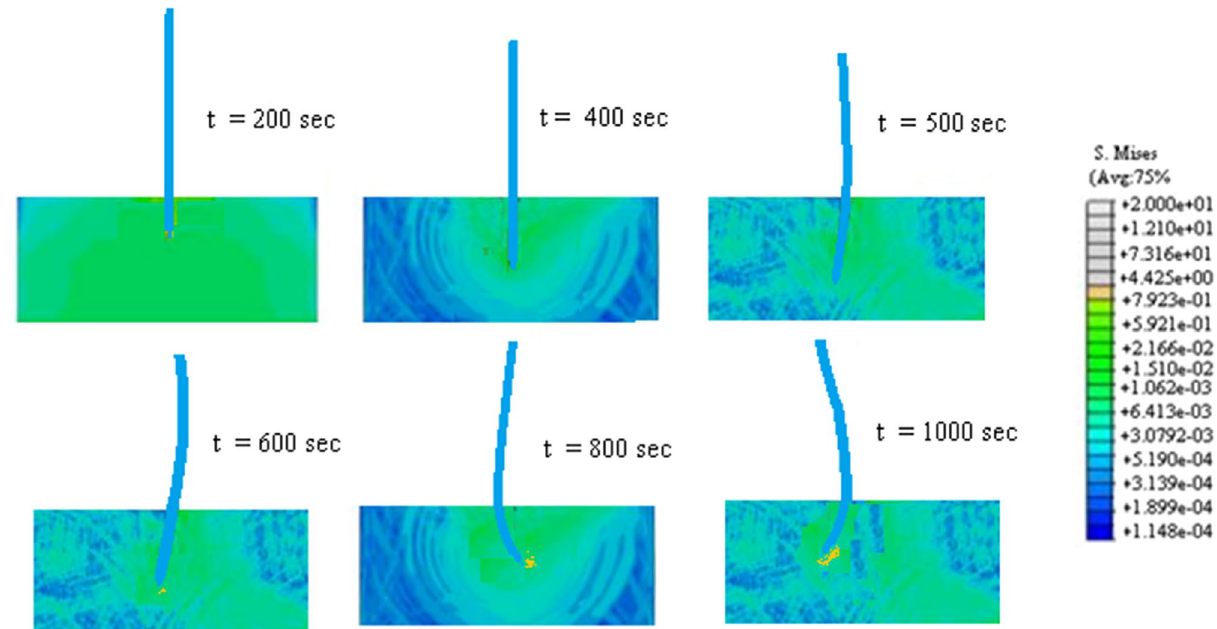
Figure 13. The deformation of the needle at t = 400, 600, 800 and 1000